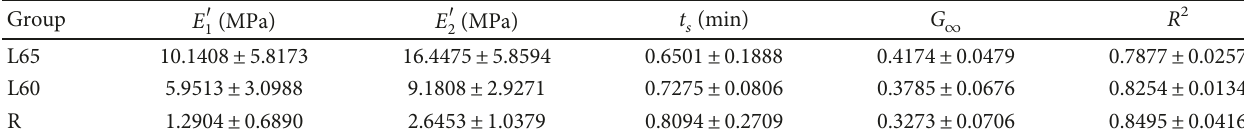
Table 4: The fi tted parameters of stress-relaxation data by model (7).